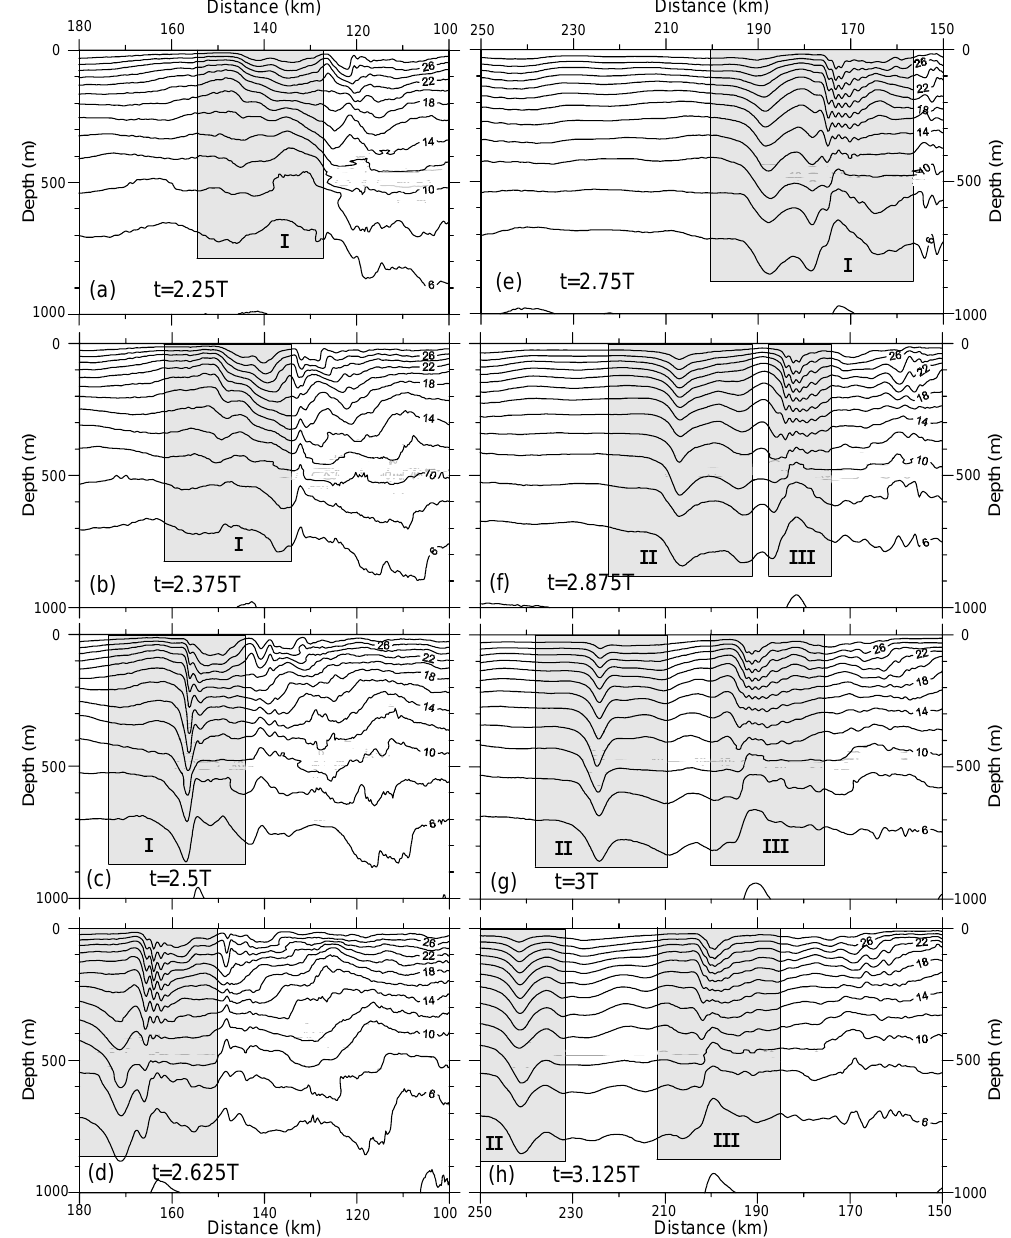
Fig. 7. Evolution of a multimodal baroclinic bore during one tidal cycle taken along the section (b), see Fig. 3.